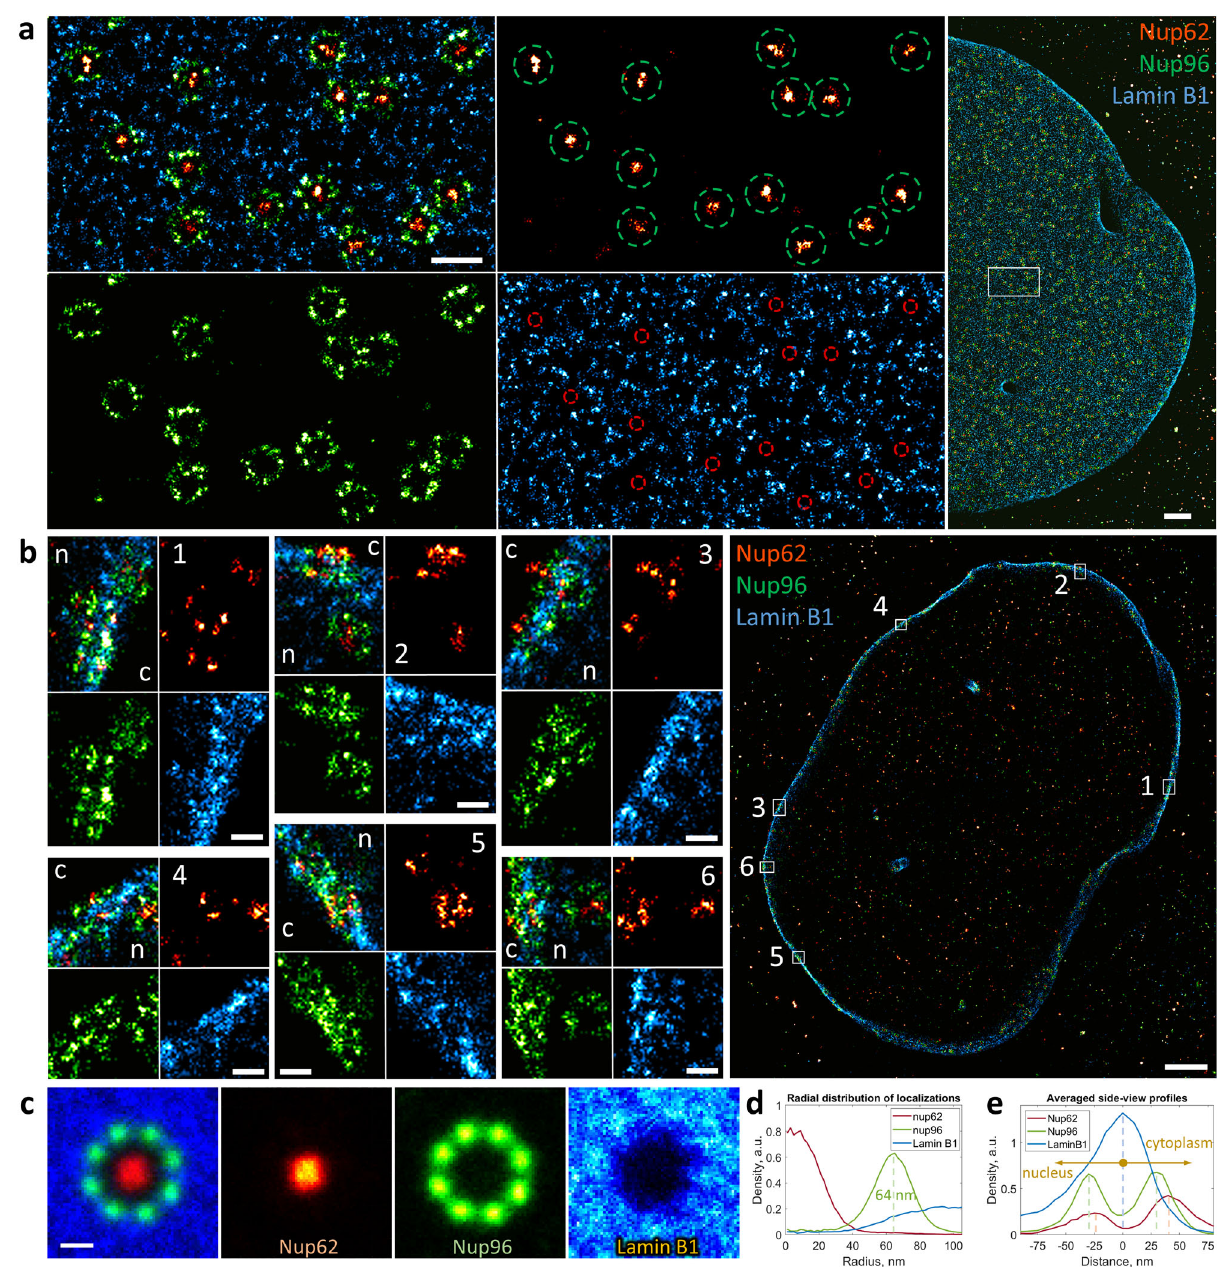
Fig. 4 Three-color splitSMLM imaging of lamin B1 at the NE. a “ Top view ” of the NE (Nup96, green; Nup62, red; lamin B1, blue). Green circles with a diameter of 150 nm represent the positions of the Nup96 ring. Red circles have a diameter of 50 nm and represent the positions of Nup62. White rectangle indicates the zoomed-in region. b “ Side views ” of the NE. The numbered rectangles in the general view represent the zoomed-in regions; n, nucleus; c, cytoplasm. c Sum of aligned images of individual NPCs. d Radial distribution of localizations of each protein obtained by averaging 99 NPC particles. e Averaged “ side view ” pro fi les of Nup62, Nup96 and lamin B1 obtained by alignment of 66 individual NPCs. Scale bars, 200 nm ( a , left), 1 µ m ( a , right and b , right), 100 nm ( b , left), 50 nm ( c